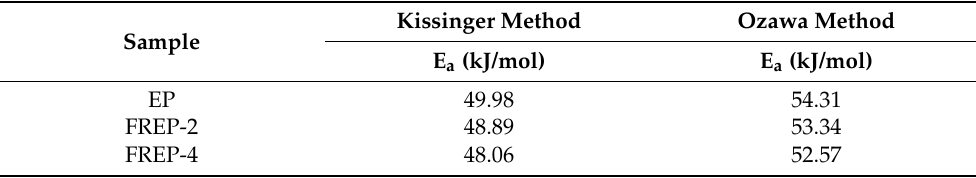
Figure 1. Non-isothermal DSC curves of the EP ( a ), FREP-2 ( b ), and FREP-4 ( c ) at different β and fitting curves of ln ( β /T p2 ) ( d ) and ln β ( e ) versus 1/T p × 10 3 . fitting curves of ln ( β /T p2 ) ( d ) and ln β ( e ) versus 1/T p × 10 3 . Table 2. E a values calculated according to the Kissinger and the Ozawa methods. Table 2. E a values calculated according to the Kissinger and the Ozawa